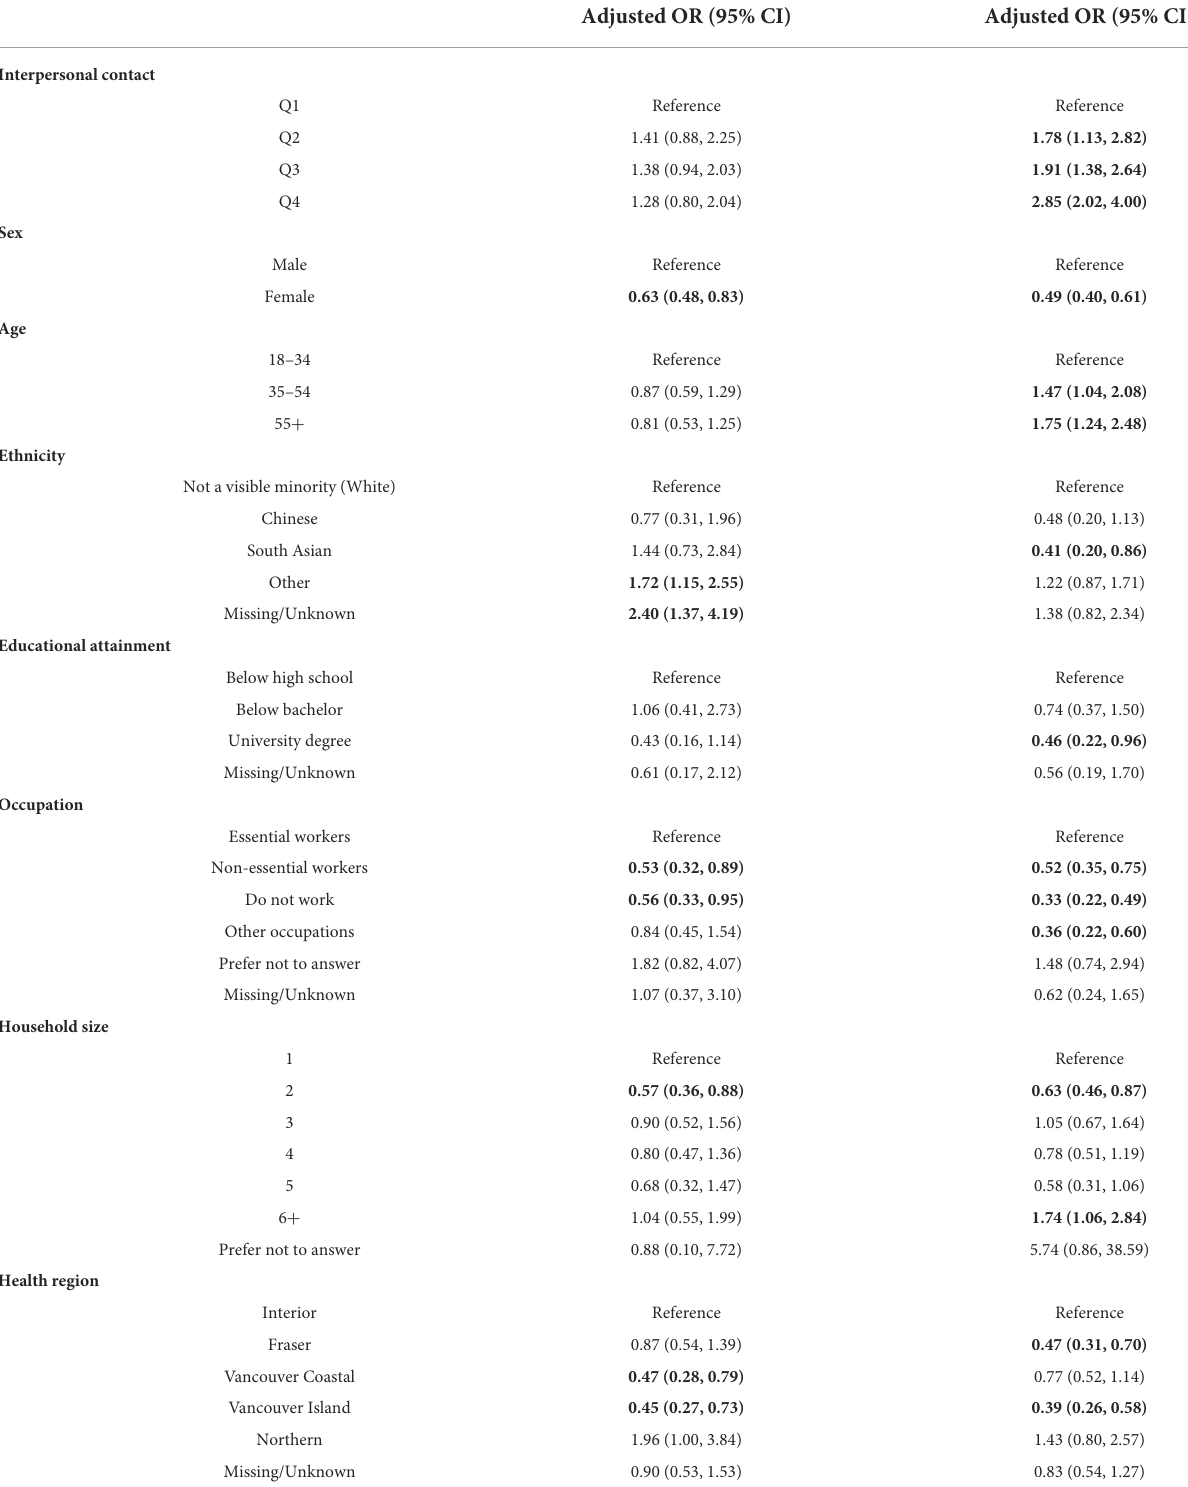
TABLE 4 Multivariable multinomial logistic regression model for association between interpersonal contact and vaccine hesitancy, March 8, 2021-December 6, 2021.